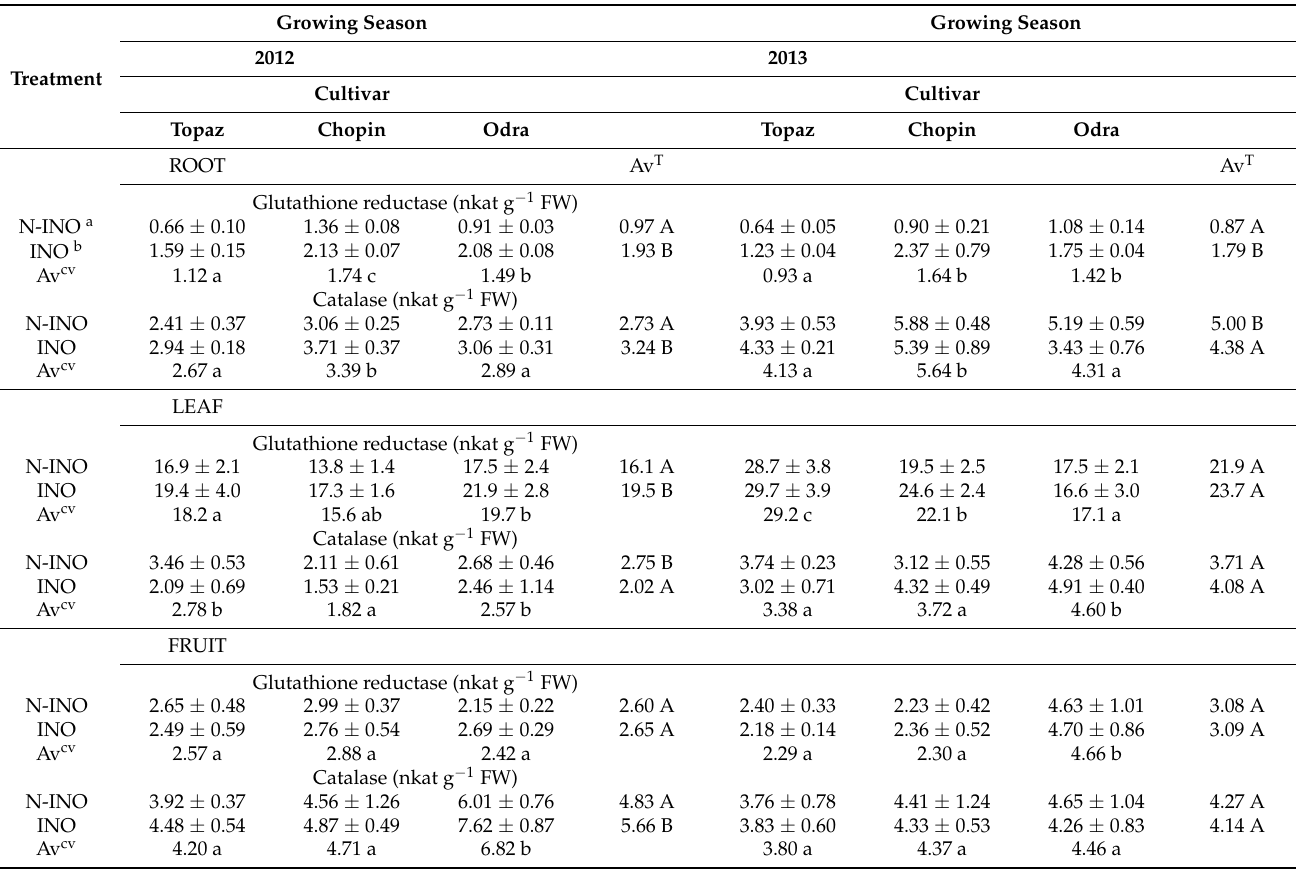
Table 2. Root, leaf, and fruit antioxidant enzyme activity: year, cultivar, and bacterial–fungal inoculation effects.